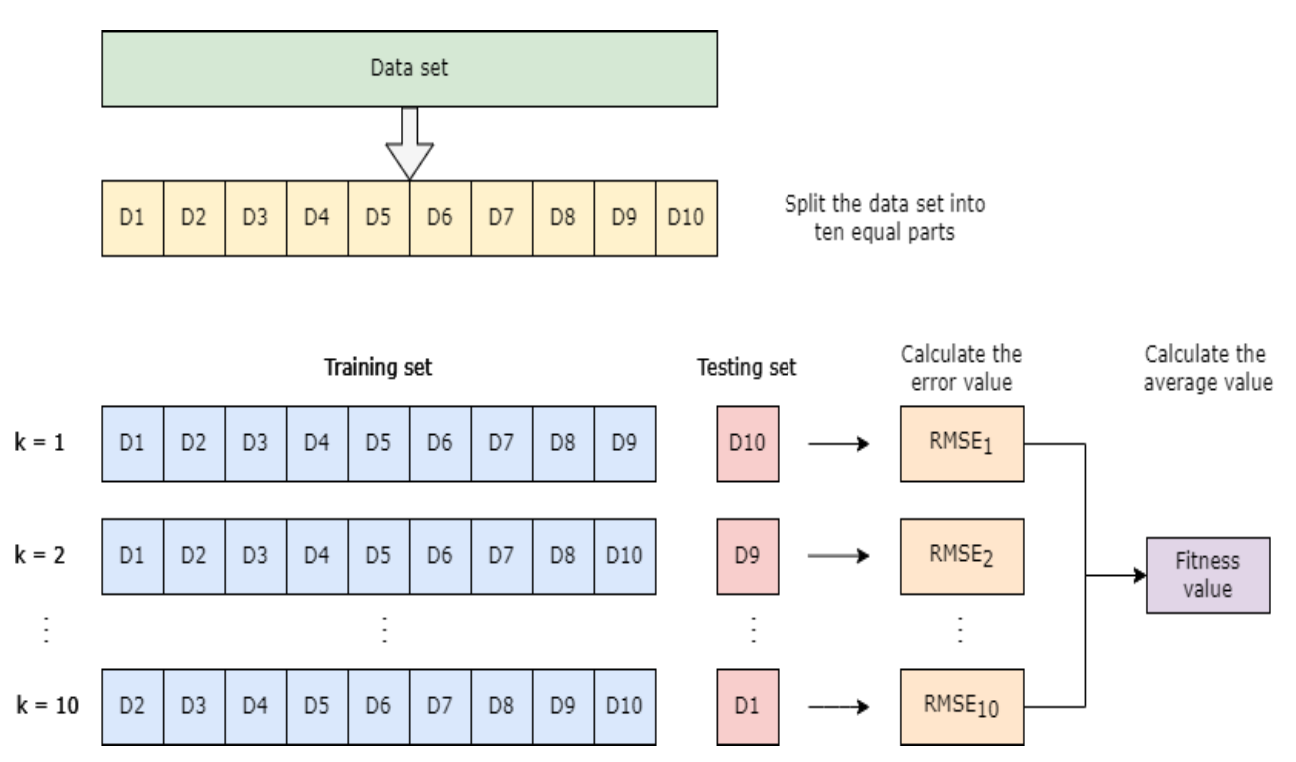
Figure 2. The schematic diagram of the fitness value calculating process.